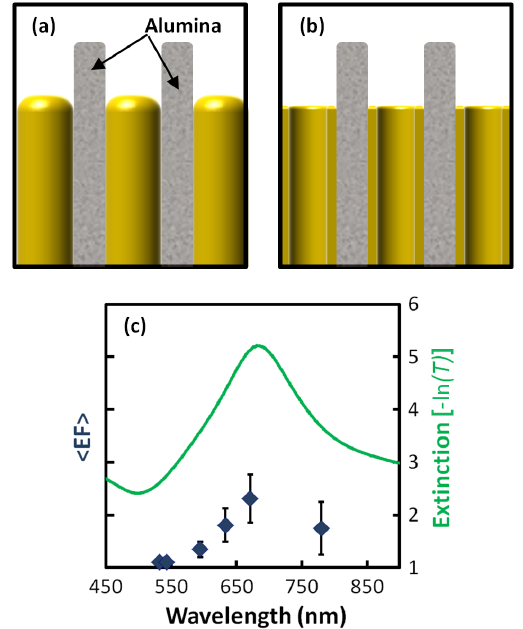
FIG. 8. Schematic illustrations of unetched gold (a) nanorod and (b) nanotube arrays still encased in the alumina template. (c) Graph showing the measured enhancement factor h EF i and optical extinction [ (cid:1) ln ð T Þ ] at normal incidence for unetched nanotubes (still encased in alumina) with average diameter of 45 nm, wall thickness of 10 nm, length of approximately 150 nm, and array period of 65 nm. The green curve indicates the optical extinction of the sample. Black-diamond data points indicate the h EF i of the 1617 - cm (cid:1) 1 band of CV. (Signal levels for this situation were very low, and therefore this Raman band was used to reduce experimental